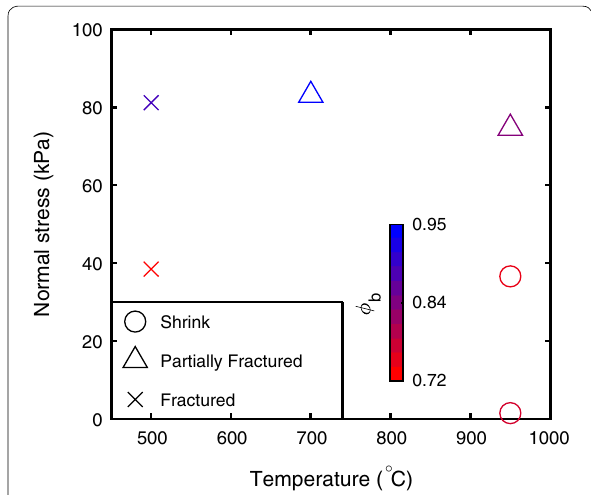
Fig. 8 Regime diagram of fracturing. Symbol shapes indicate the occurrence of fracturing, and the symbol color indicates the initial porosity, as denoted by the color